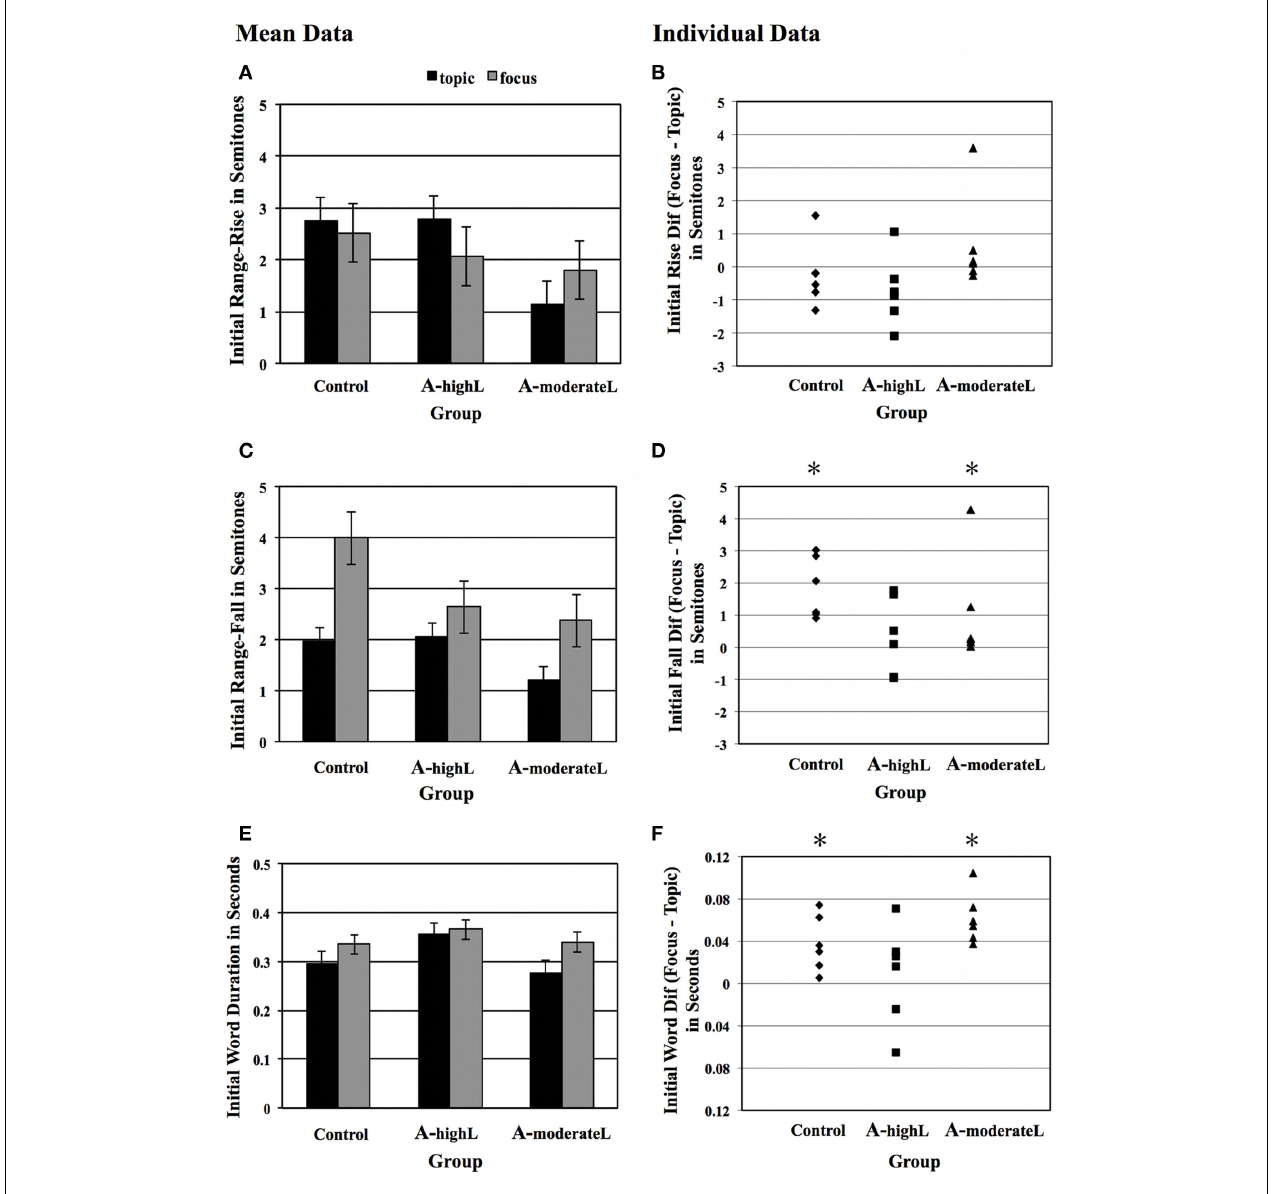
Mean range-fall and SE by group. (D) Individual data for range-fall difference (focus–topic) by group. (E) Mean word duration and SE by group. (F) Individual data for duration difference (focus–topic) by group. * p <